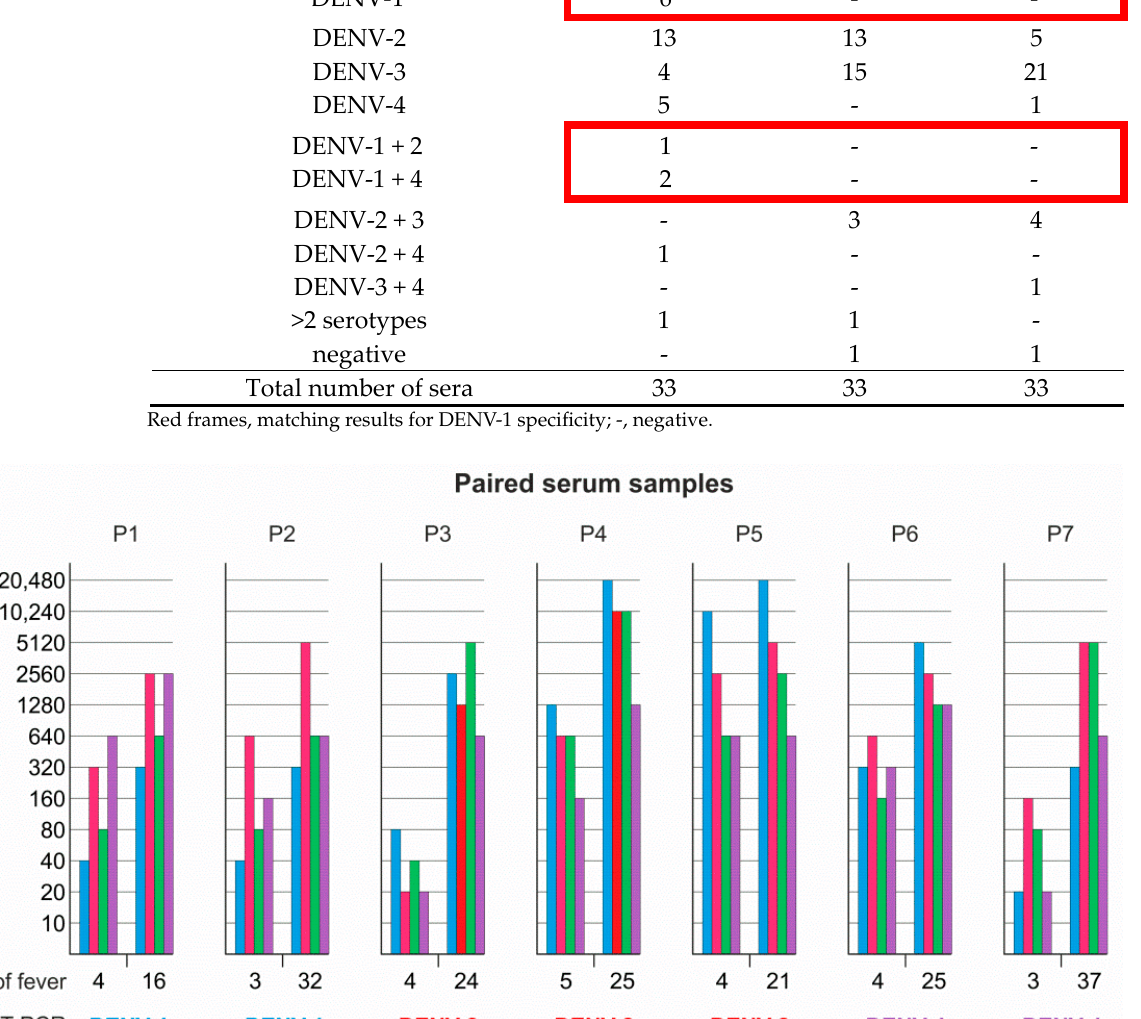
Figure 3. ED3 amino acid sequences used for ED3 ELISA and ED3 dot assay. Sequence differences between the same serotype are marked in red. Amino acid differences between REF:COL for DENV ‐ 1, S339T, P364S, A369T; for DENV ‐ 2, V308I, I310R, V324I, M340T, T359I; for DENV ‐ 3, L303T, G342E, K385N, R393K; for DENV ‐ 4, I351V, F357L, Y360N, V379M, D384N.